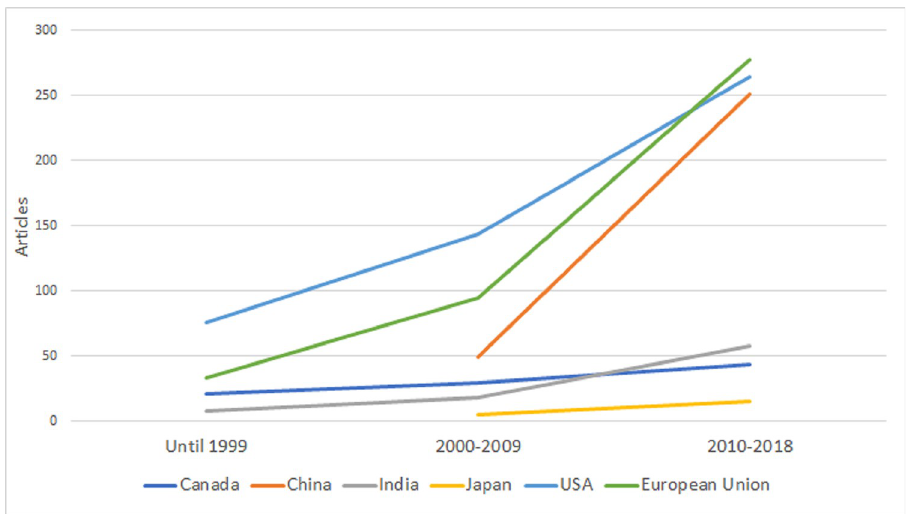
Fig 4. Evolution of published articles in the field of biocontrol using Beauveria bassiana strains. The vertical axis represents the number of articles published in each of the 3 periods analyzed (until 1999, 2000–2009, and 2010–2018) by country (Canada, China, Japan, and the USA) or regulatory region (European Union).